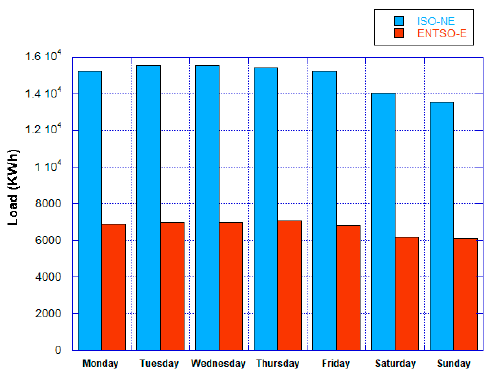
Figure 1. Average daily power consumption of each dataset.